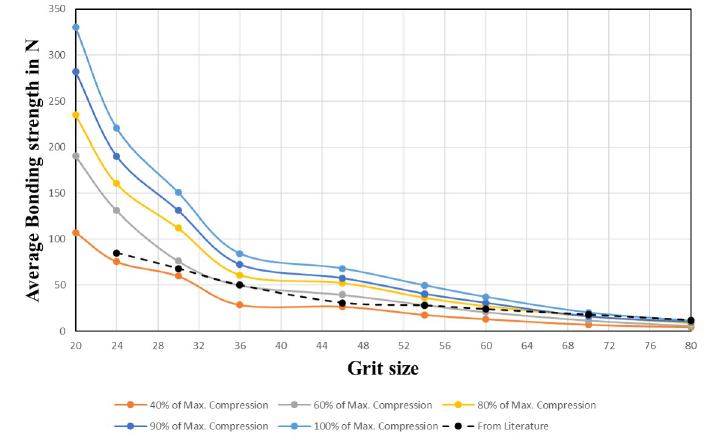
Figure 19. Average bonding strength depending on compression for different grit sizes; literature values from [38] (p. 116).